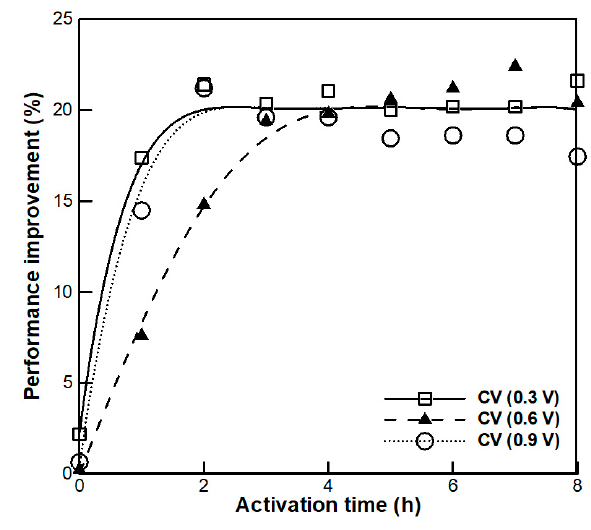
Figure 4. Performance improvement of constant voltage (CV) mode conditioning depending on activation time.